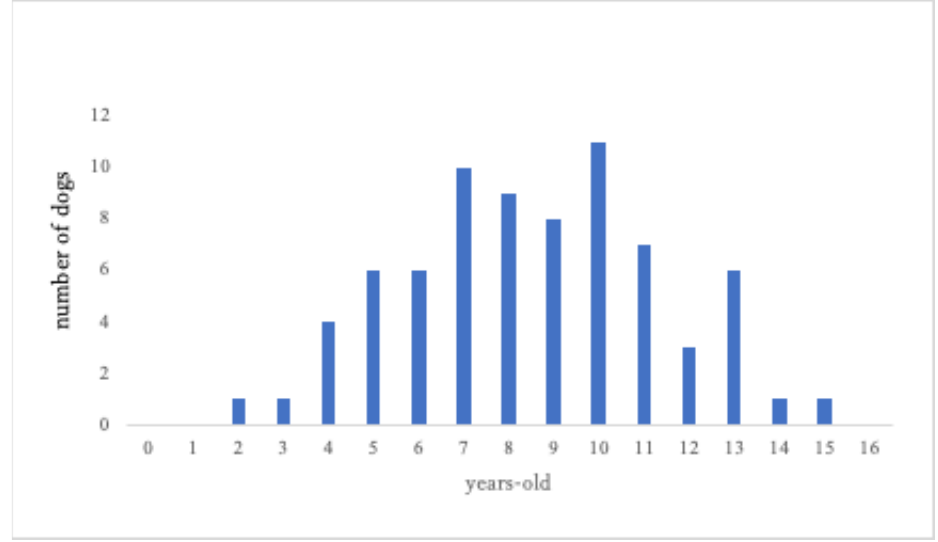
Figure 1. Age distribution of 74 active dogs.